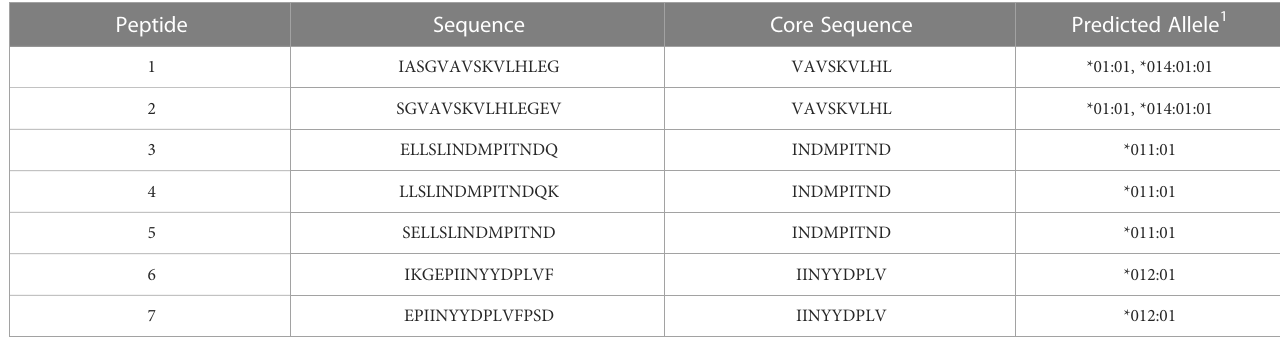
TABLE 4 Computationally predicted BoLA Class II peptides.